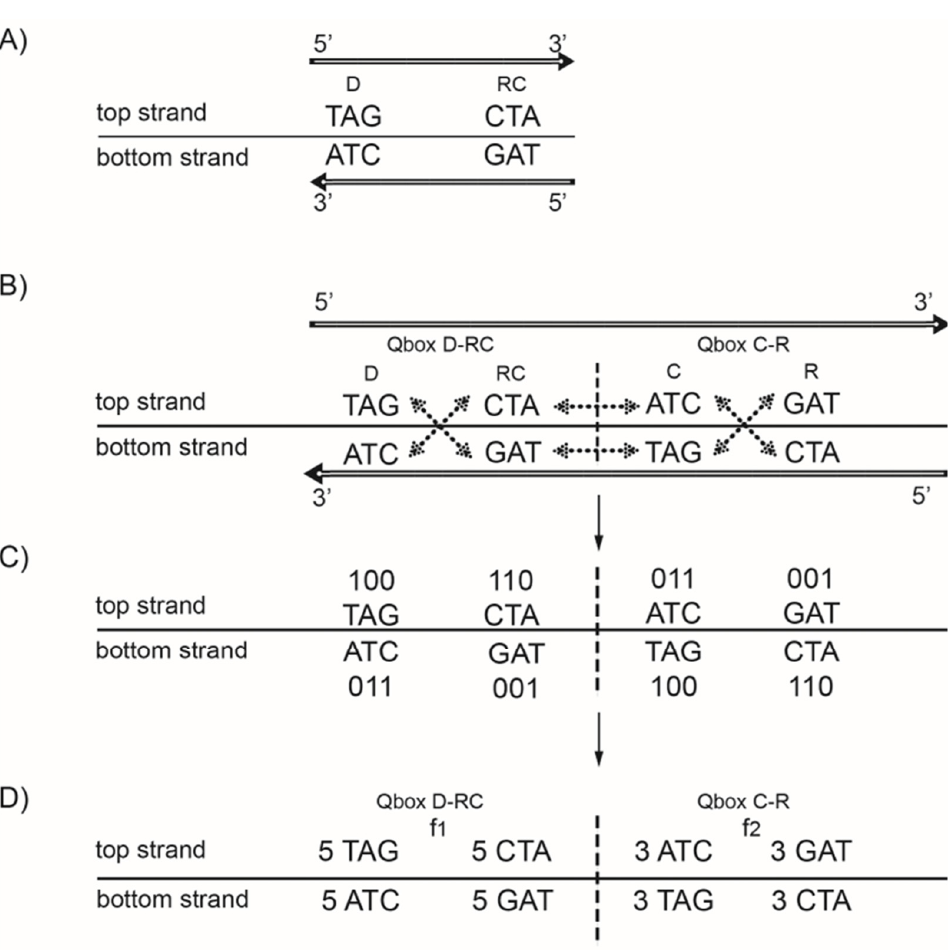
Figure 2. The difference between strand symmetry and quadruplet symmetry for triplets. ( A ) Strand symmetry includes in the same strand of only the direct (D) and reverse complement (RC) of a triplet. Reading bidirectionally, as pointed by the direction of the arrow, the same trinucleotides appear in both strands. Therefore, only one strand is considered in the determination of strand symmetry (the top strand). Thus, the DNA is reduced to a binary system. However, in this way, symmetries among trinucleotides are not evident. ( B ) Quadruplet symmetry includes the whole quadruplet of trinucleotides: direct (D), reverse complement (RC) as well as the complement (C) and reverse (R) in both strands of DNA. The quadruplet boxes QboxD-R and QboxC-R are created with mirror symmetries between the strands and between the boxes. Thus, each quadruplet consists of structural symmetries, creating an esthetical form of “butterfly” mirror symmetry, and the DNA is reduced to a quartic system. ( C ) The same quadruplet mirror symmetries are present in the purine–pyrimidine relationship: 0 is assigned to purines (A, G), and 1 is assigned to pyrimidines (T, C). ( D ) All members of the same box have the same frequencies ( f D = f RC, respectively, f C = f R), but frequencies between the boxes mutually differ. For quadruplets with symmetric trinucleotides, such as AGA or CTC, there is no difference in frequencies between boxes. However, frequencies in both strands of DNA for each individual quadruplet are identical regardless of whether the trinucleotides are symmetric or asymmetric ( f D = f RC = f C = f R), such as in our example: (D) 5 TAG (top strand) + 3 TAG (bottom strand) = 8 TAG; (RC) 5 CTA (top strand) + 3 CTA (bottom strand) = 8 CTA; (C) 5 ATC (bottom strand) + 3 ATC (top strand) = 8 ATC; and (R) 5 GAT (bottom strand) + 3 GAT (top strand) = 8 GAT.